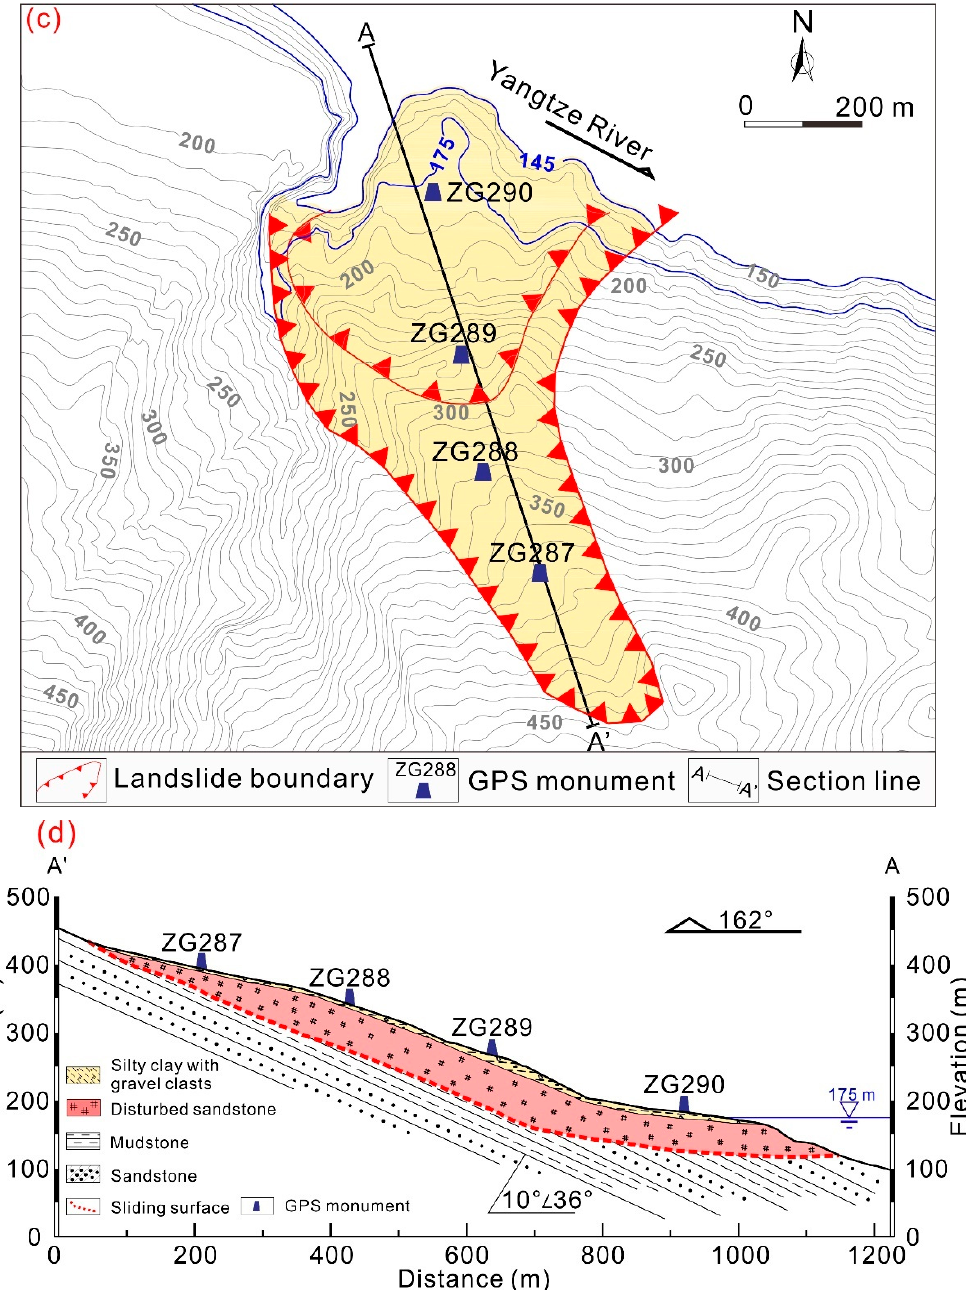
Figure 4. Topographic map and geological profile of the Fanjiaping landslide. ( a ) Topographic map of the Muyubao landslide. ( b ) Geological profile of the Muyubao landslide along sections A–A ′ , as recorded with monitoring instruments. ( c ) Topographic map of the Tanjiahe landslide. ( d ) Geological profile of the Tanjiahe landslide along sections B–B ′ , as recorded with monitoring instruments.